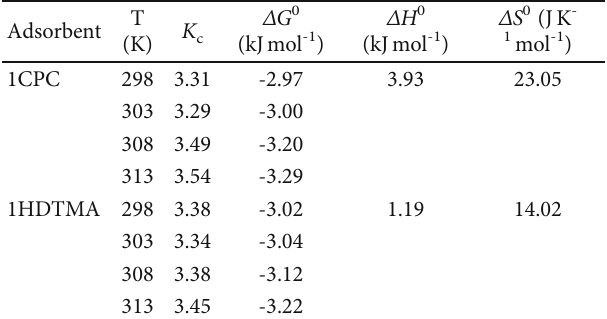
Table 5: Cr concentration in the sample after adsorption. Cr Concentration of Cr valency Adsorbent in powder (mgg -1 ) state